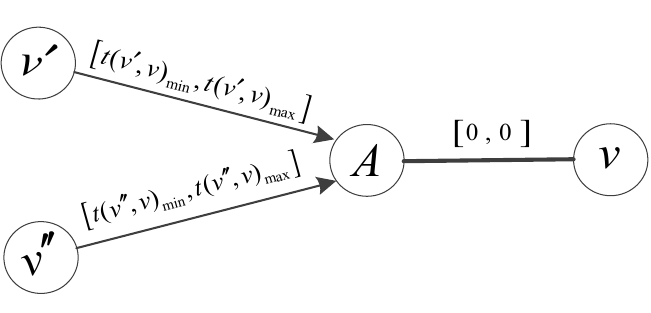
Figure 3. Transformation of the OR discrepancy node.